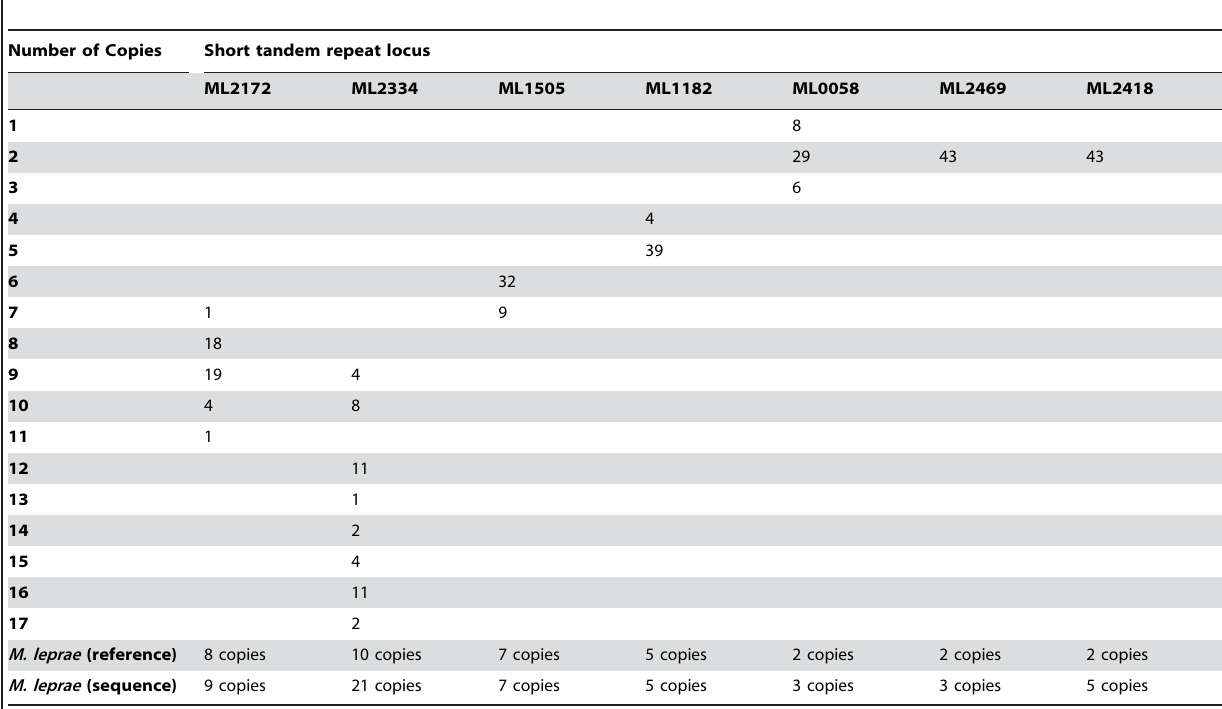
Repeat sequence